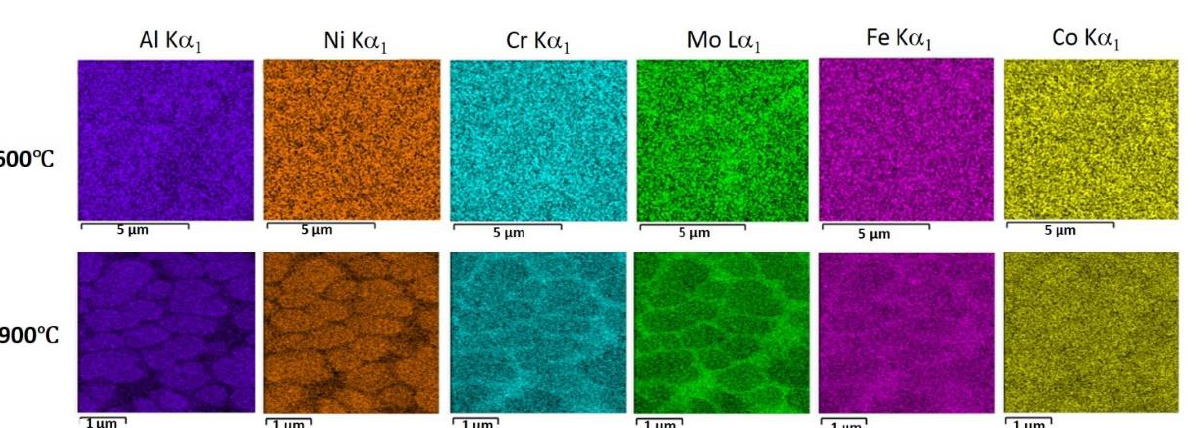
Figure 5. EDS mapping of the powders annealed at 600 °C and 900 °C.